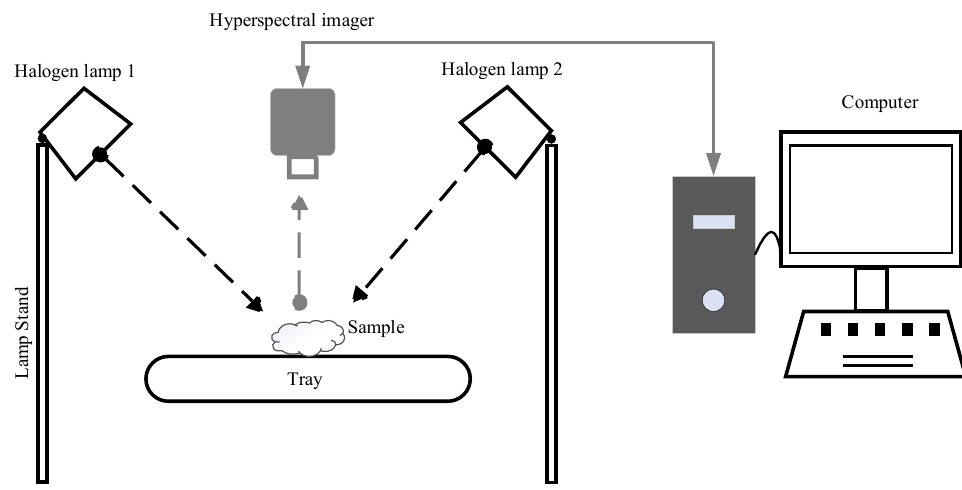
Figure 3. Schematic diagram of the hyperspectral imaging system in the laboratory.